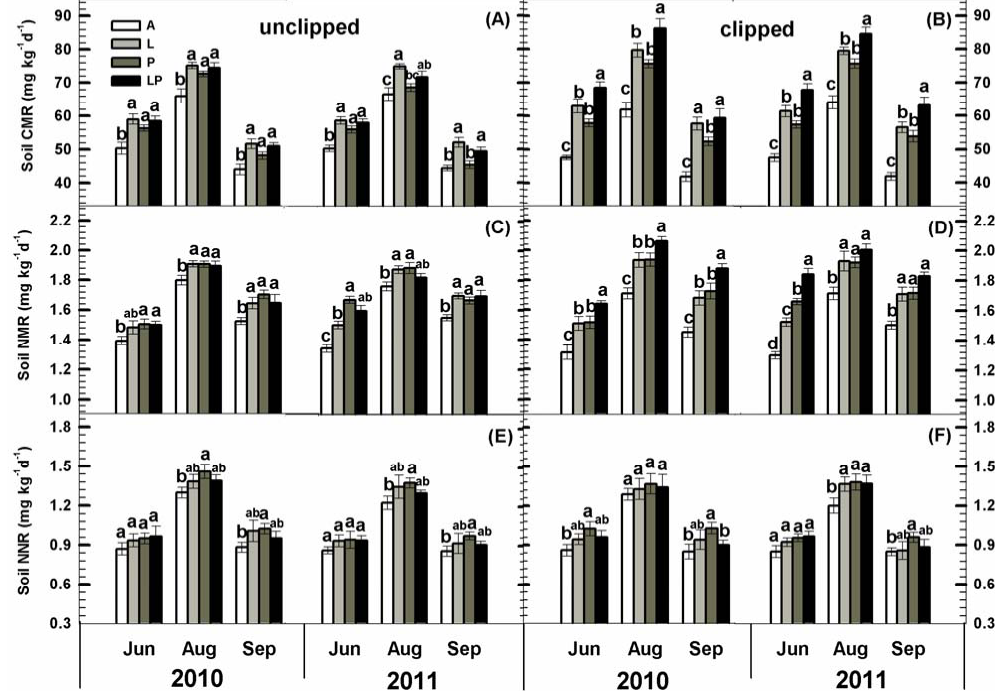
Fig. 5. Seasonal dynamics of soil C mineralization rate (CMR), net N mineralization rate (NMR) and net nitrification rate (NNR) under belowground particulate litter addition ( + 60%), increased precipitation ( + 30%) and clipping in the temperate steppe of northeastern China. Values show the monthly means in 2010 and 2011. Vertical bars indicate standard error of means ( n = 6). Different lowercase letters indicate statistically significant differences ( P < 0.05). See Fig. 2 for